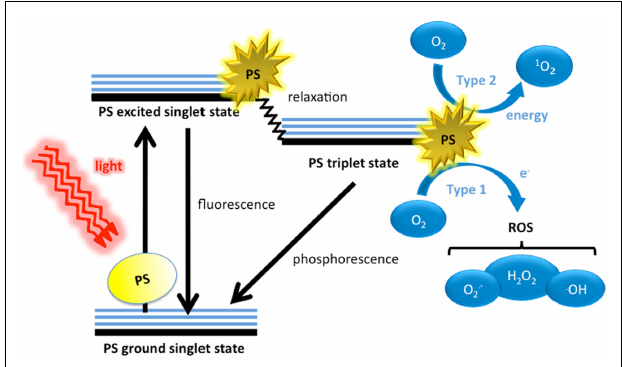
FIGURE 1 | Schematic illustration of photodynamic therapy including the Jablonski diagram. The PS initially absorbs a photon that excites it to the first excited singlet state and this can relax to the more long lived triplet state.This triplet PS can interact with molecular oxygen in two pathways, type I and type II, leading to the formation of reactive oxygen species (ROS) and singlet oxygen